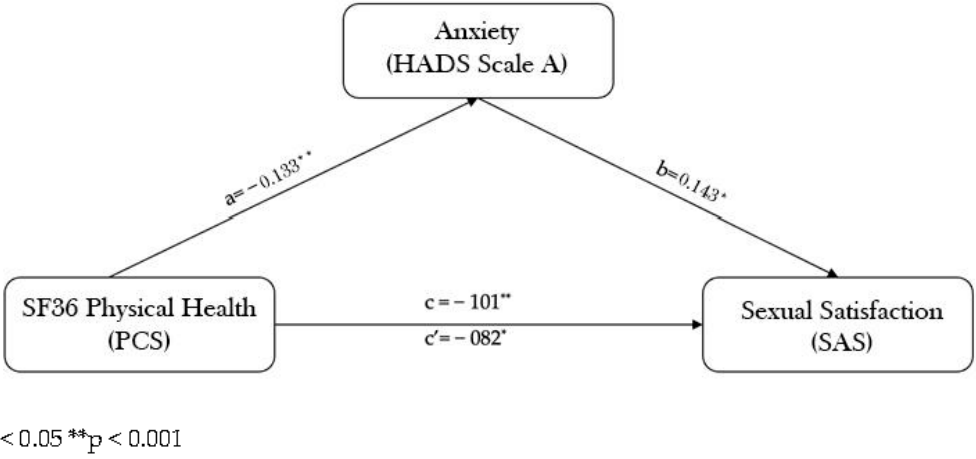
Figure 2. Mediating role of anxiety.